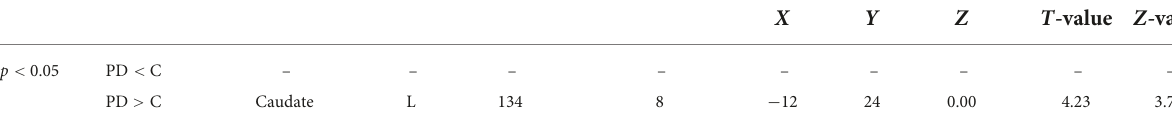
TABLE 4 Cerebrospinal fluid alterations detected by VBM. P -value Contrast Anatomical region L/R Size (Voxels) No. of clusters